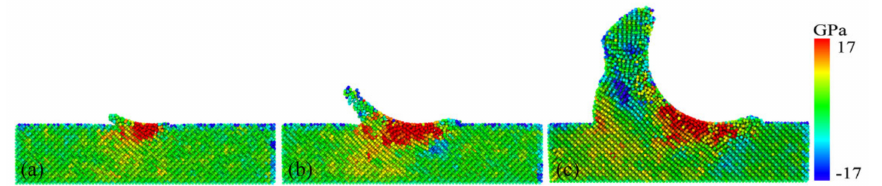
Figure 11. Hydrostatic pressure distribution at different asperity sizes of ( a ) 2 nm, ( b ) 4 nm and ( c ) 7